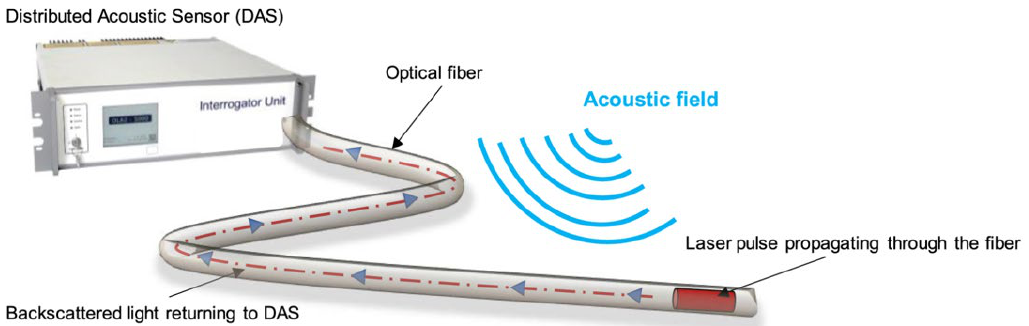
Figure 2. The principle of DAS measurement [12].